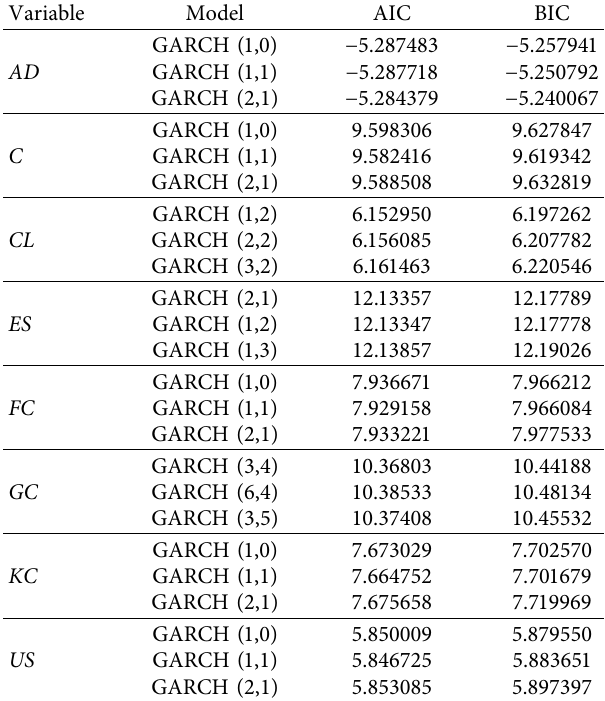
Figure 2: Forecast for 30 daily close price values. (a) Forecasts from ARIMA (0,1,1) for AD. (b) Forecasts from ARIMA (0,1,1) for C. (c) Forecasts from ARIMA (0,1,2) for CL. (d) Forecasts from ARIMA (1,1,1) for ES. (e) Forecasts from ARIMA (0,1,1) for FC. (f) Forecasts from ARIMA (0,1,1) for GC. (g) Forecasts from ARIMA (1,1,1) for KC. (h) Forecasts from ARIMA (0,1,1) for US. Table 6: Suggested GARCH models from EACF and AIC for